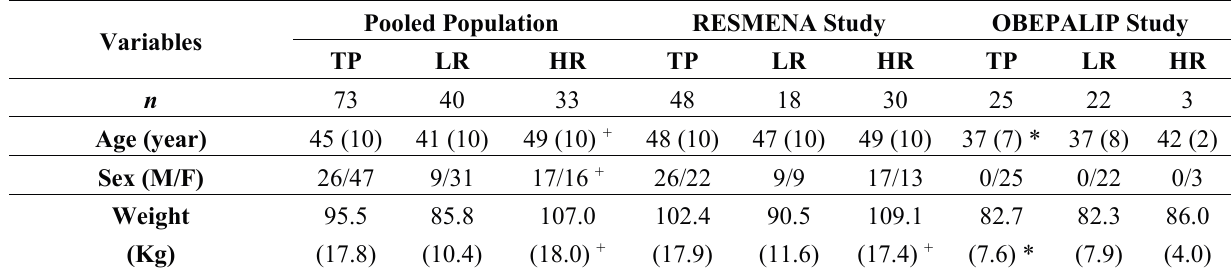
Table 1. General characteristics of the studied